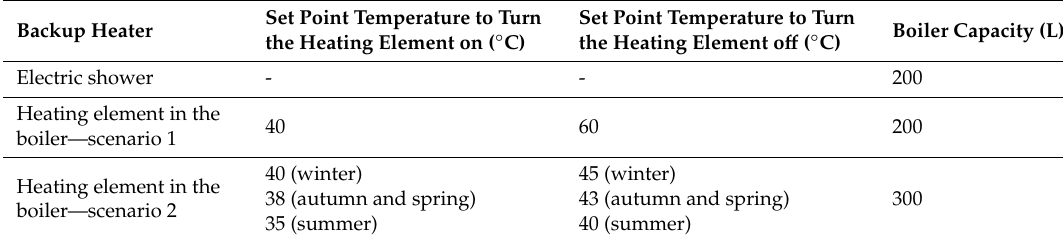
Table 4. Solar water heating systems simulated.